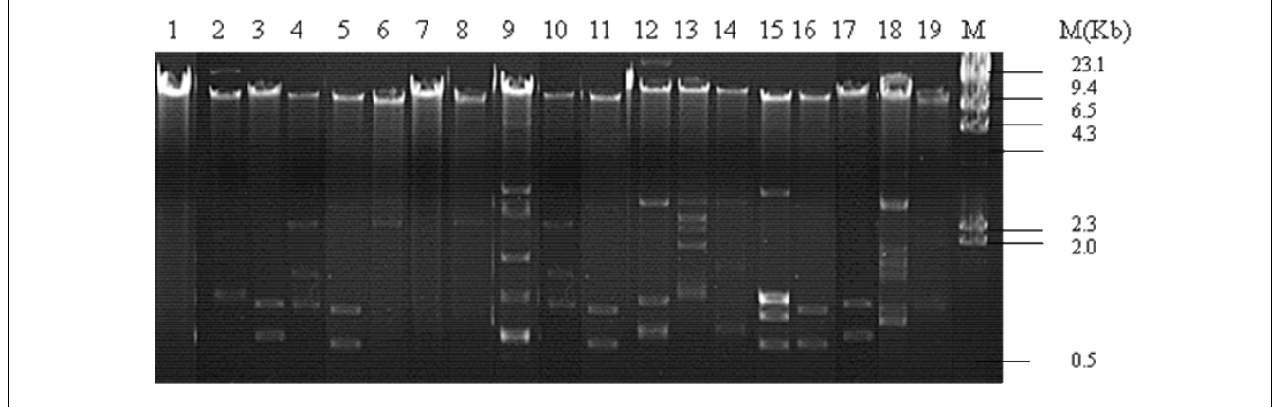
FIGURE 1 | Plasmid pattern of clinical uropathogenic E. coli isolates. Lanes 1–19, plasmid extracted from the clinical isolates ( n = 19) and electrophoresed on 0.8% agarose gel. M, lambda/ Hin dII DNA ladder.